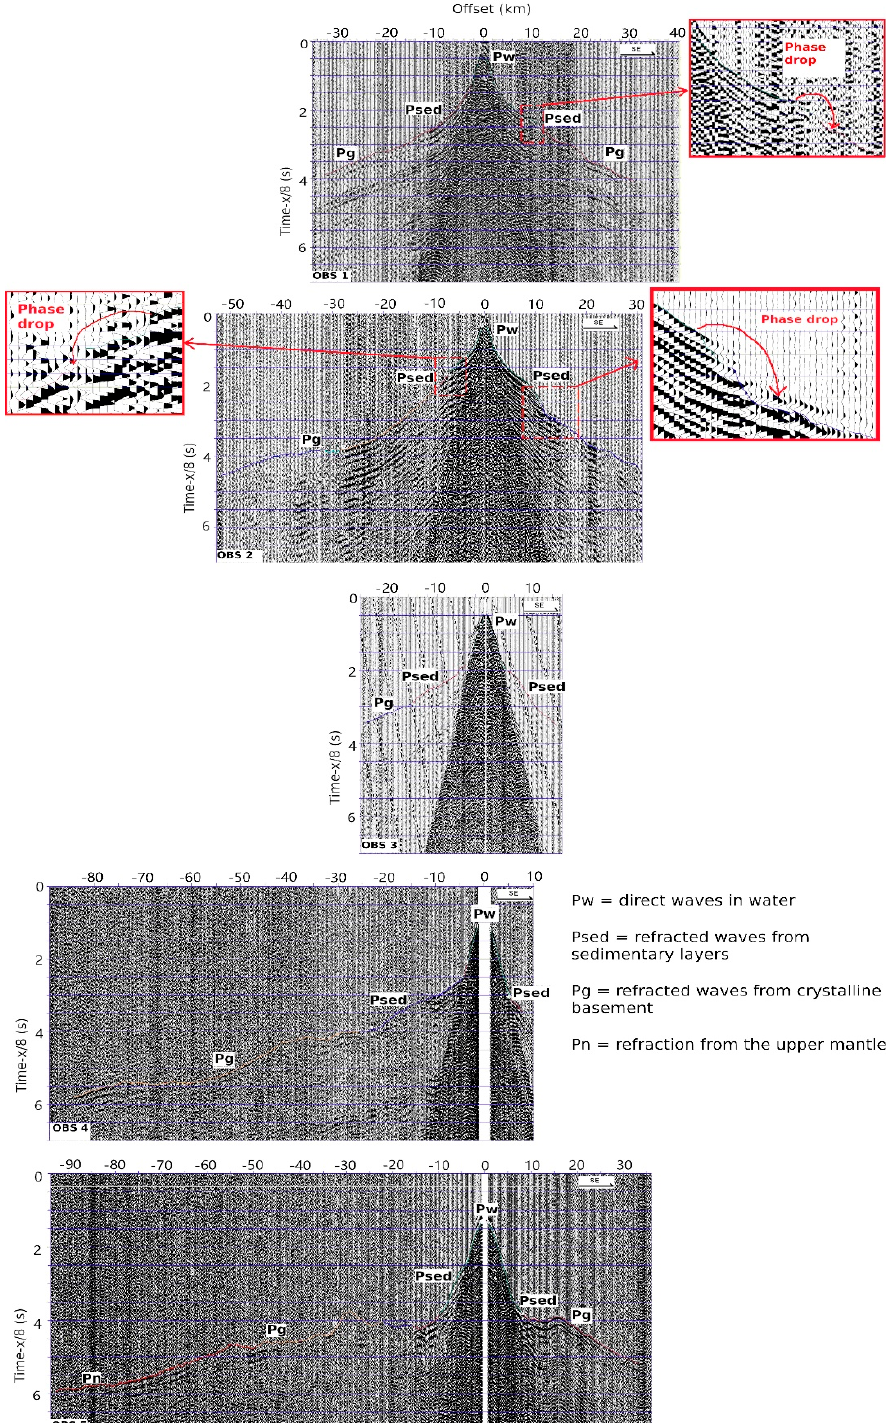
Figure 3. OBS 1–5 records. Dotted colour lines denote picks of the first arrivals.